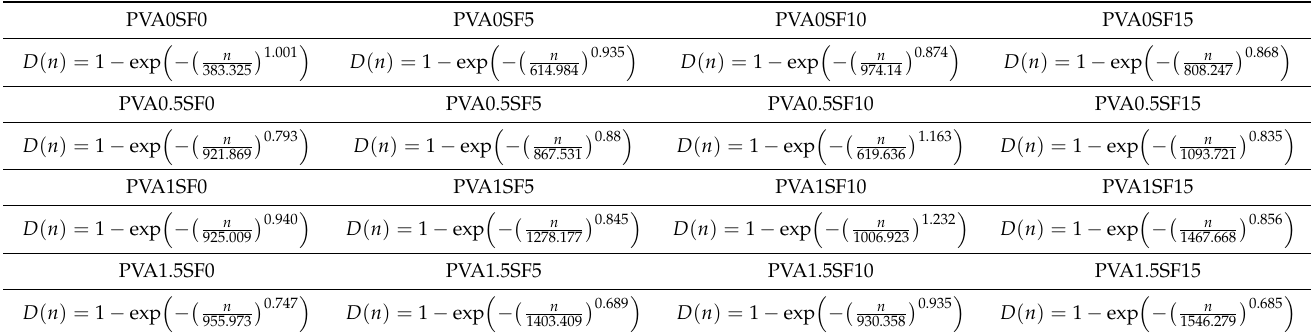
Table 5. Freeze-thaw damage evolution